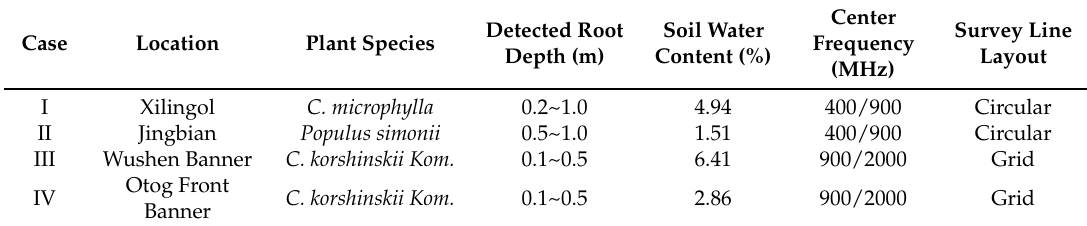
Table 1. Experiment conditions of the four in situ